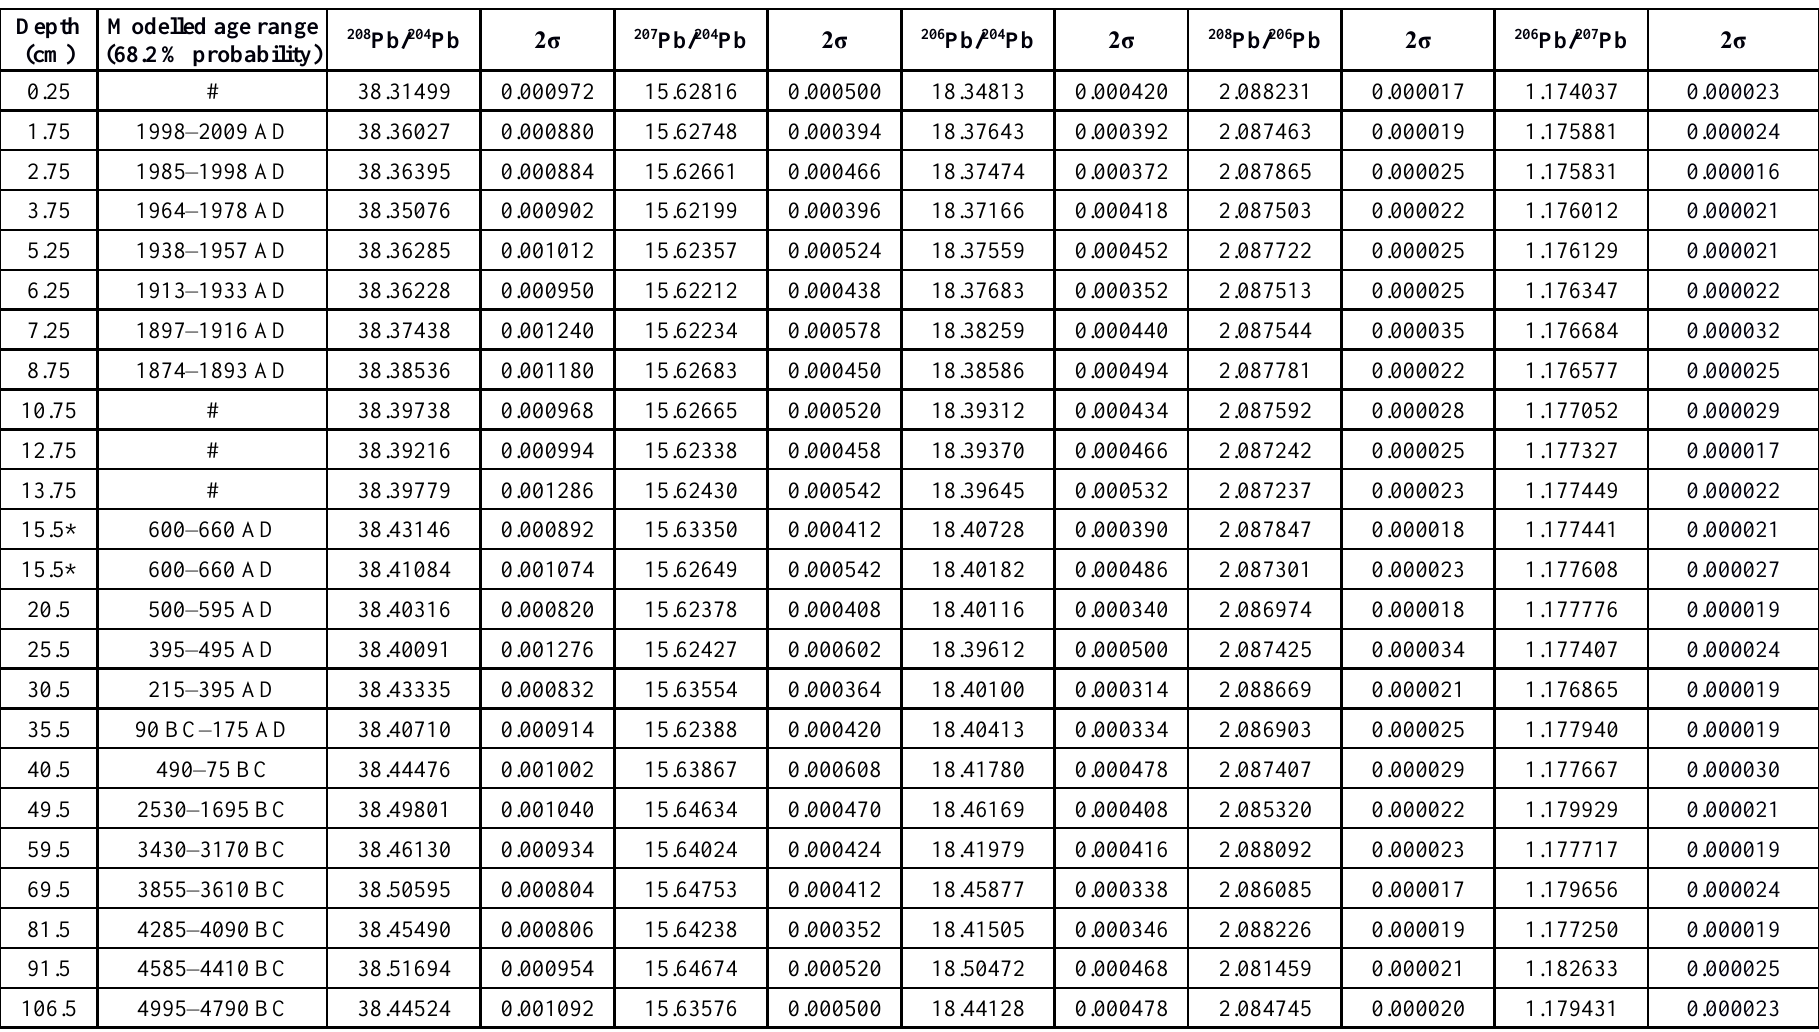
Table 1. Lead isotope quotients of samples from Core W3 with 2σ uncertainty. Replicates are indicated by asterisks (*). For depths indicated by #, values were not calculated in the age-depth